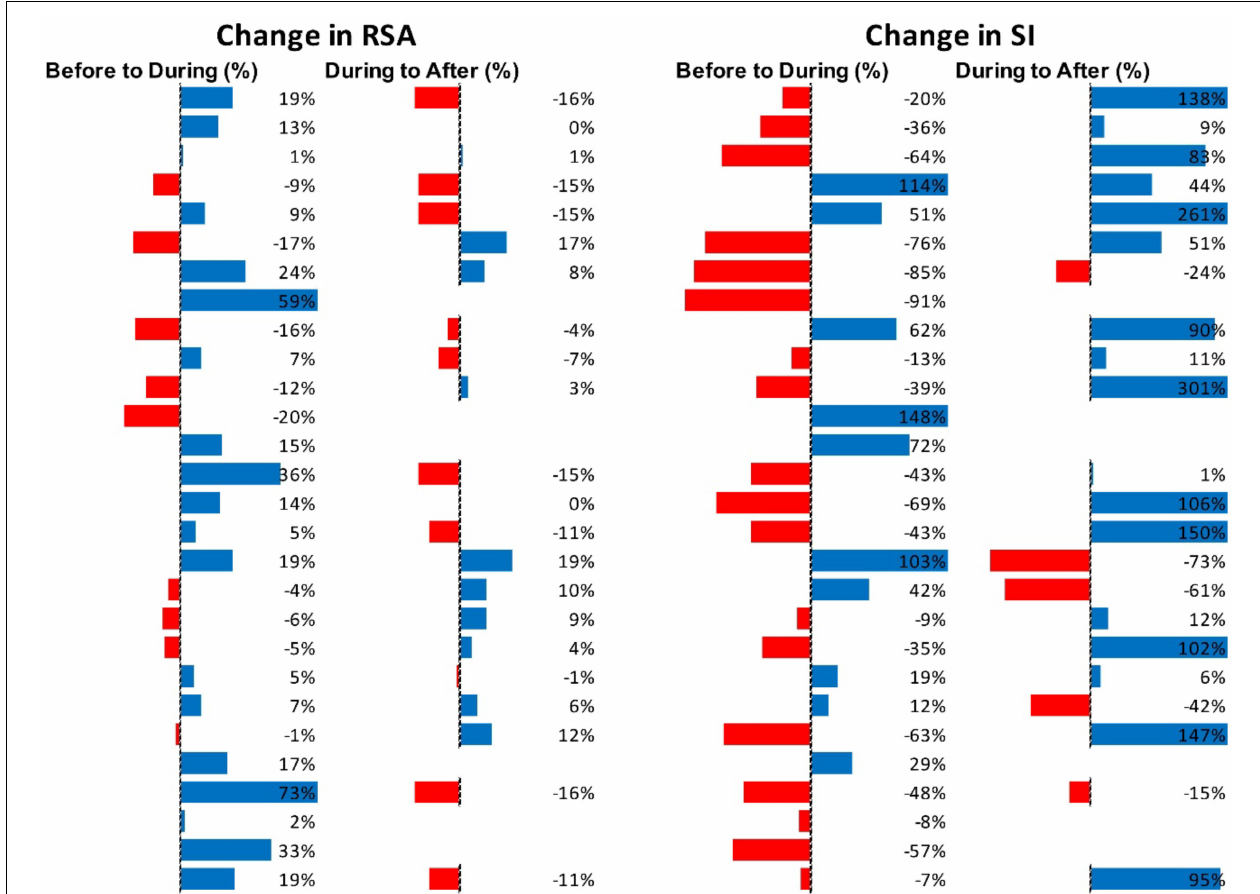
FIGURE 9 | Changes in autonomic activity in response to all HAPW’s ( N = 28). Data are shown as % change. The Friedman test was applied for assessment of significance followed by Dunn’s multiple comparisons test. RSA: before to during, not significant; during to recovery, not significant. SI: before to during p = 0.0389; during to recovery, p = 0.004